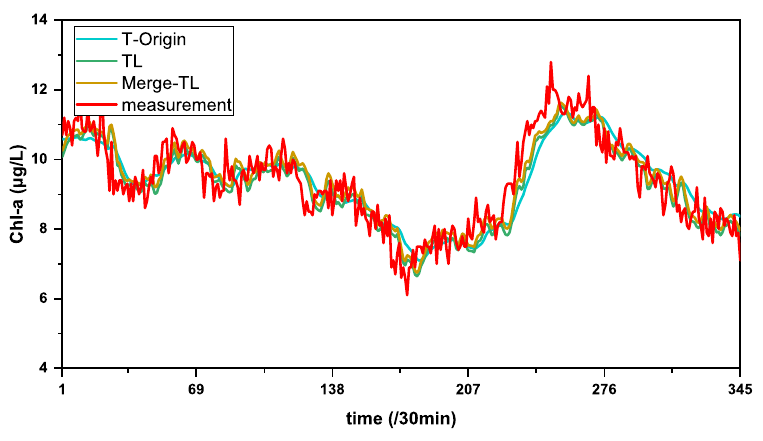
Figure 6. Results of the ablation experiments, where the total number of the prediction data points is 345 and the corresponding time period is from 19:30 on 23 September to 23:30 on 30 September. The MAE, RMSE, MSE, and MAPE for the Merge-TL models are all the smallest, with each value decreasing by 9.93%, 10.09%, 19.15%, and 9.53%, respectively, compared to